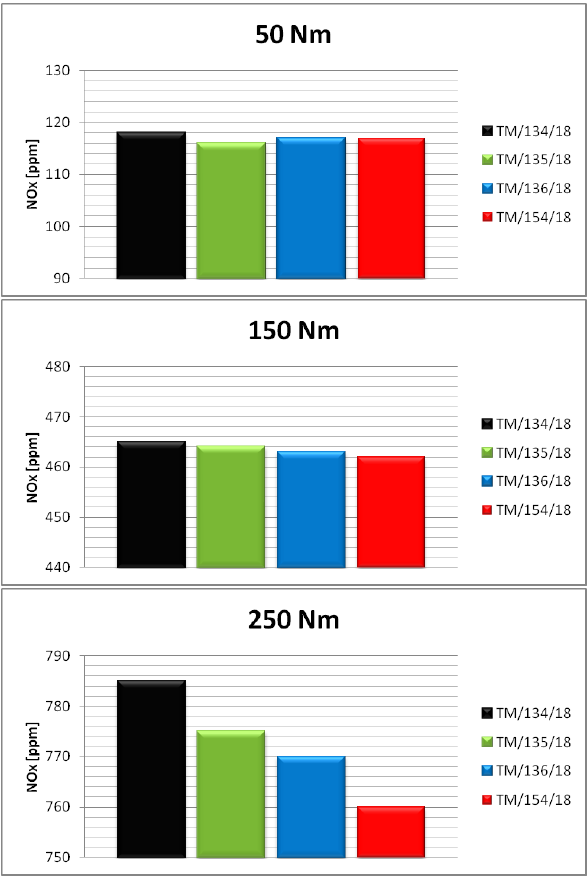
Fig. 3. NO x concentration in exhaust gas in selected duty points of the engine for the four tested fuels